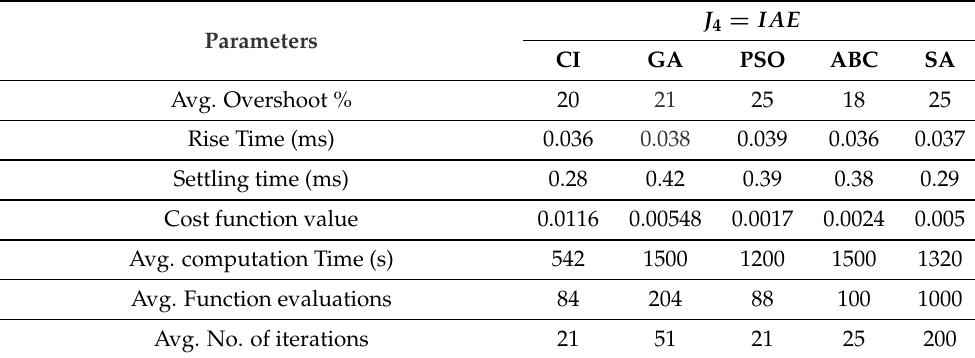
Table 7. Comparison of different optimization methods for the cost function